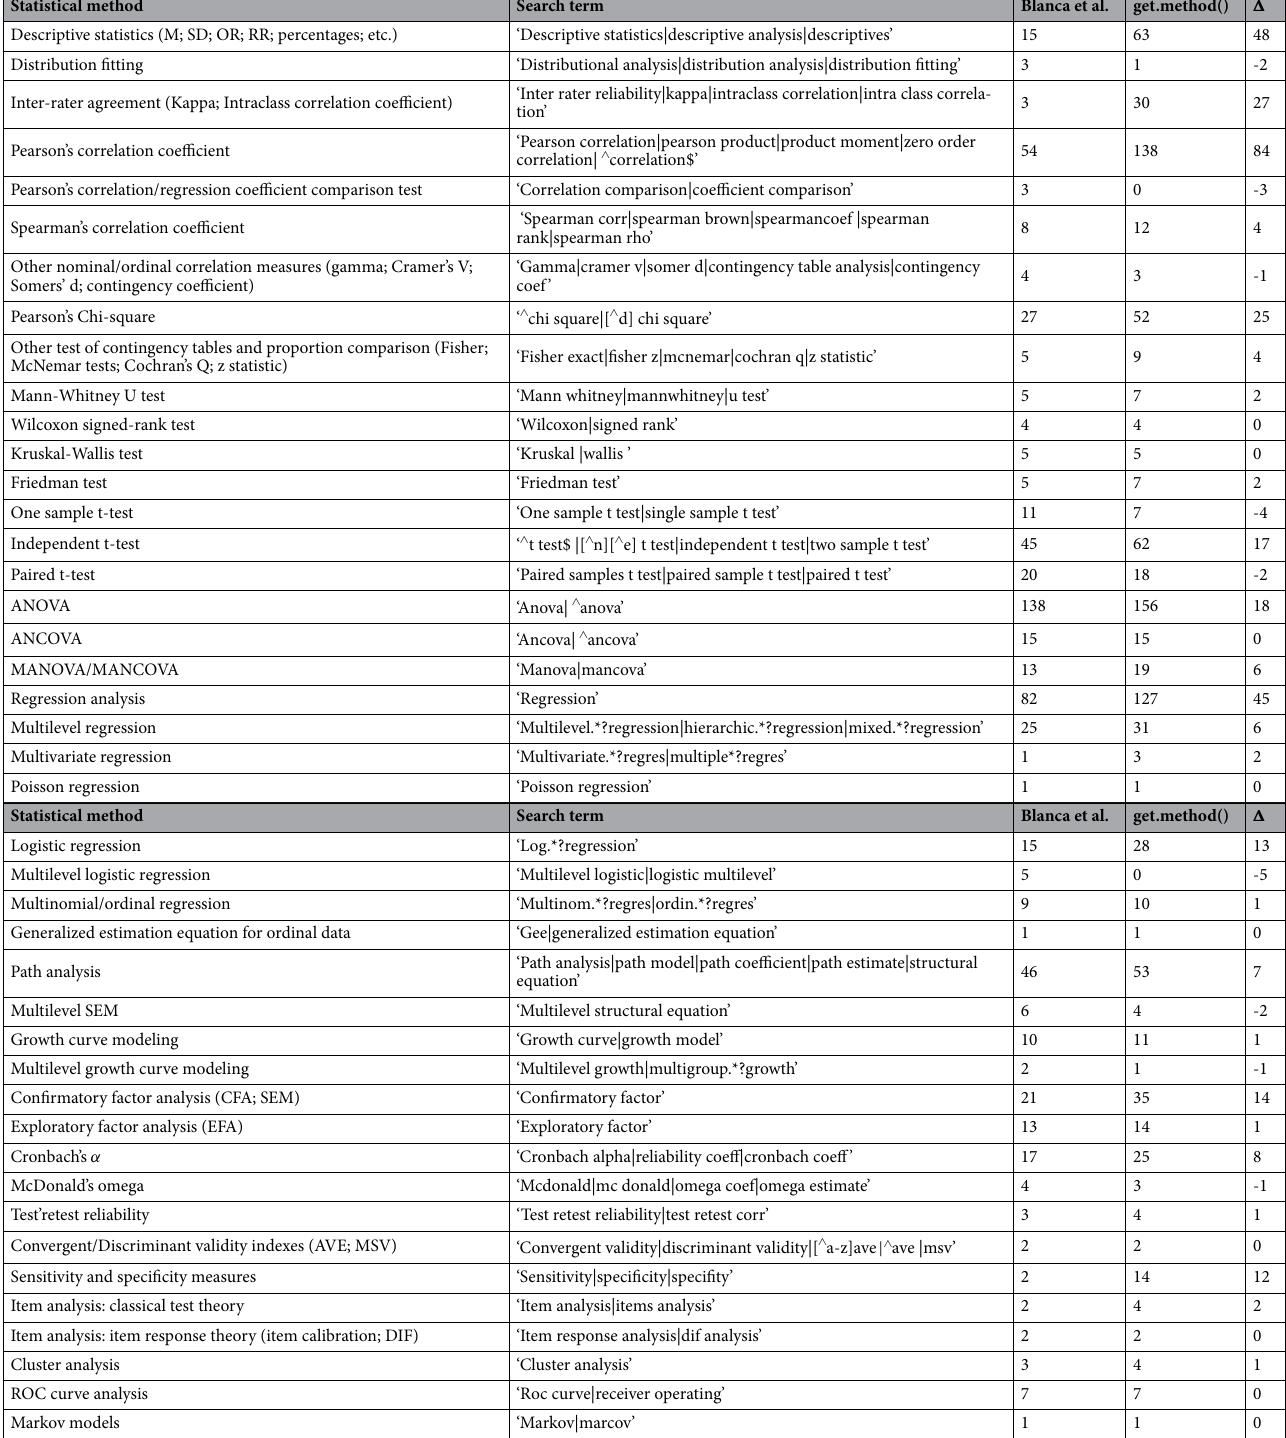
Table 2. Number of articles with mentions of specific statistical methods extracted with study.character and frequency of main analytical methods reported in Blanca et al.’s Table